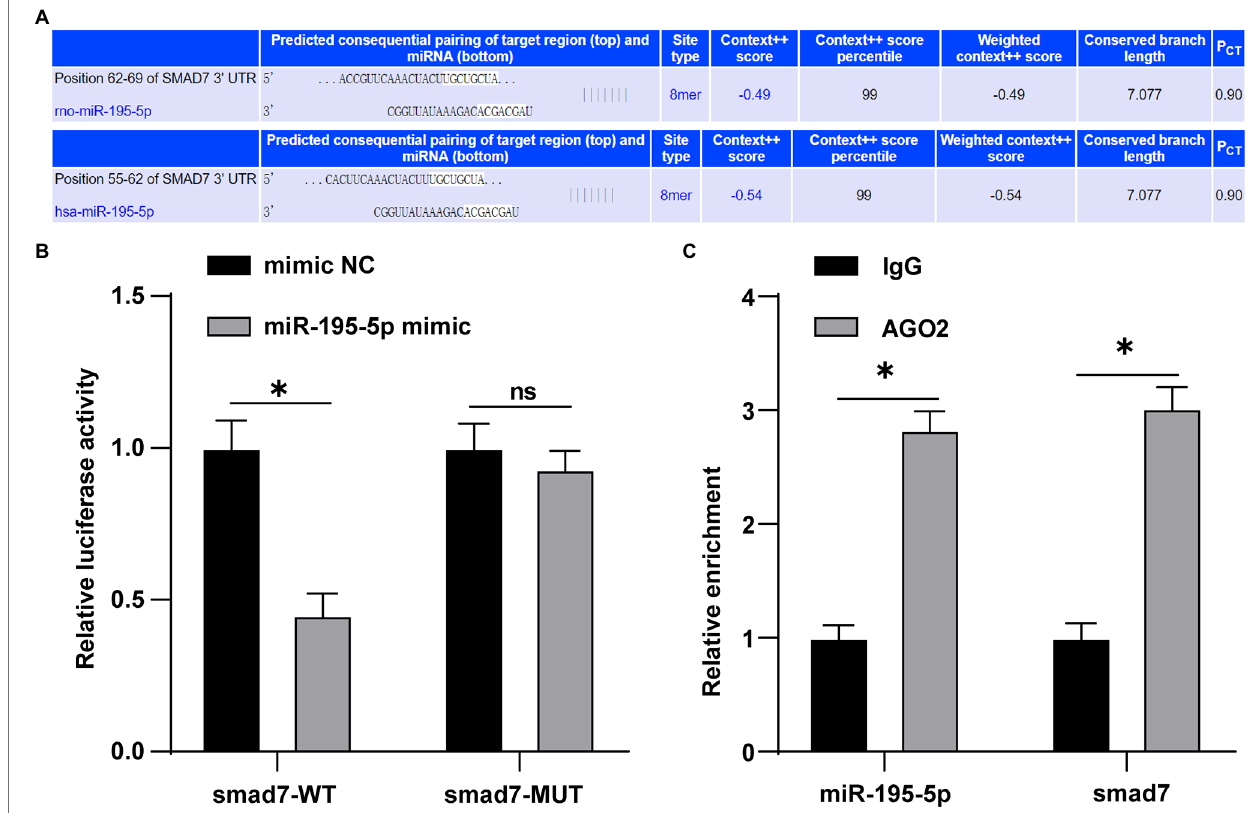
FIGURE 6 | miR-195-5p can bind to smad7. (A) TargetScan (http://www.targetscan.org/vert_71/) predicted the binding of miR-195-5 and smad7; (B) Dual- luciferase assay showed that miR-195-5 could bind smad7; and (C) RNA immunoprecipitation (RIP) assay showed that miR-195-5 could bind to smad7; the cell experiment was repeated three times. The data were expressed as mean ± SD, and analyzed by independent t test; * p <